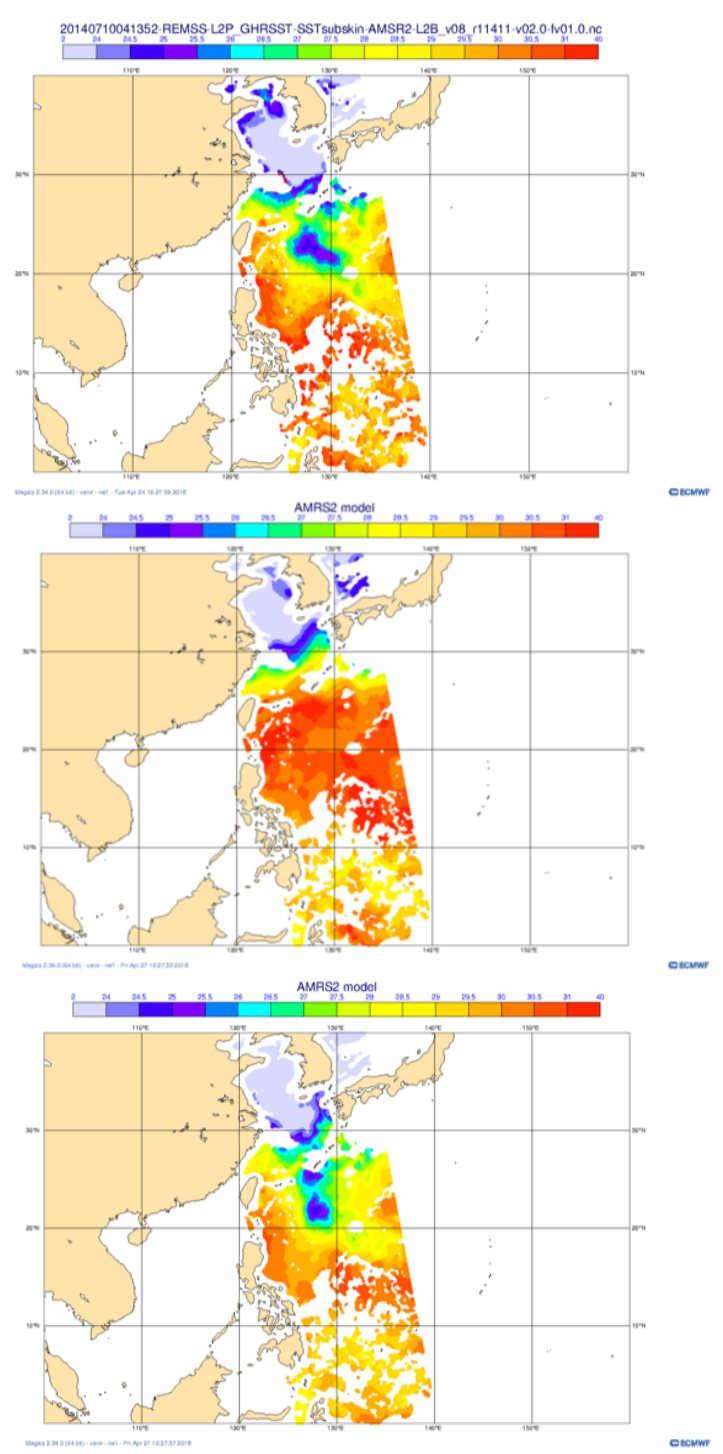
Figure 22. AMSR2 Observations of SST on 10 July 2014 after the passage of Tropical Cyclone Neoguri ( upper ), ECMWF uncoupled day-5 forecast ( middle ), ECMWF coupled ocean forecast ( lower ) valid at observation